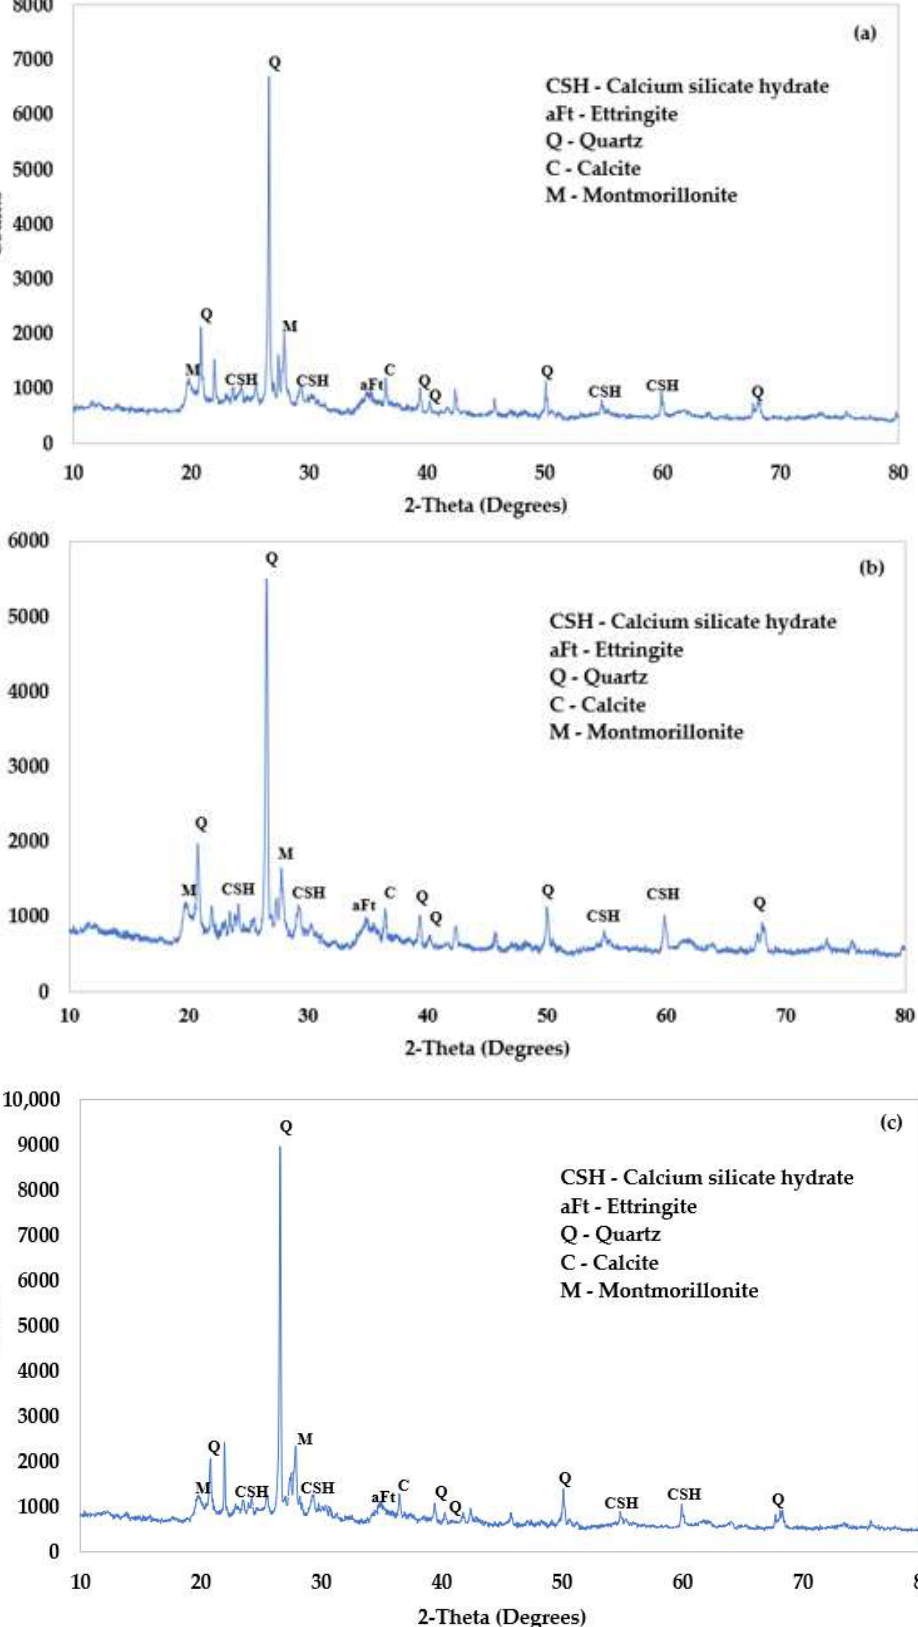
Figure 7. SEM Micrograph of LP3.